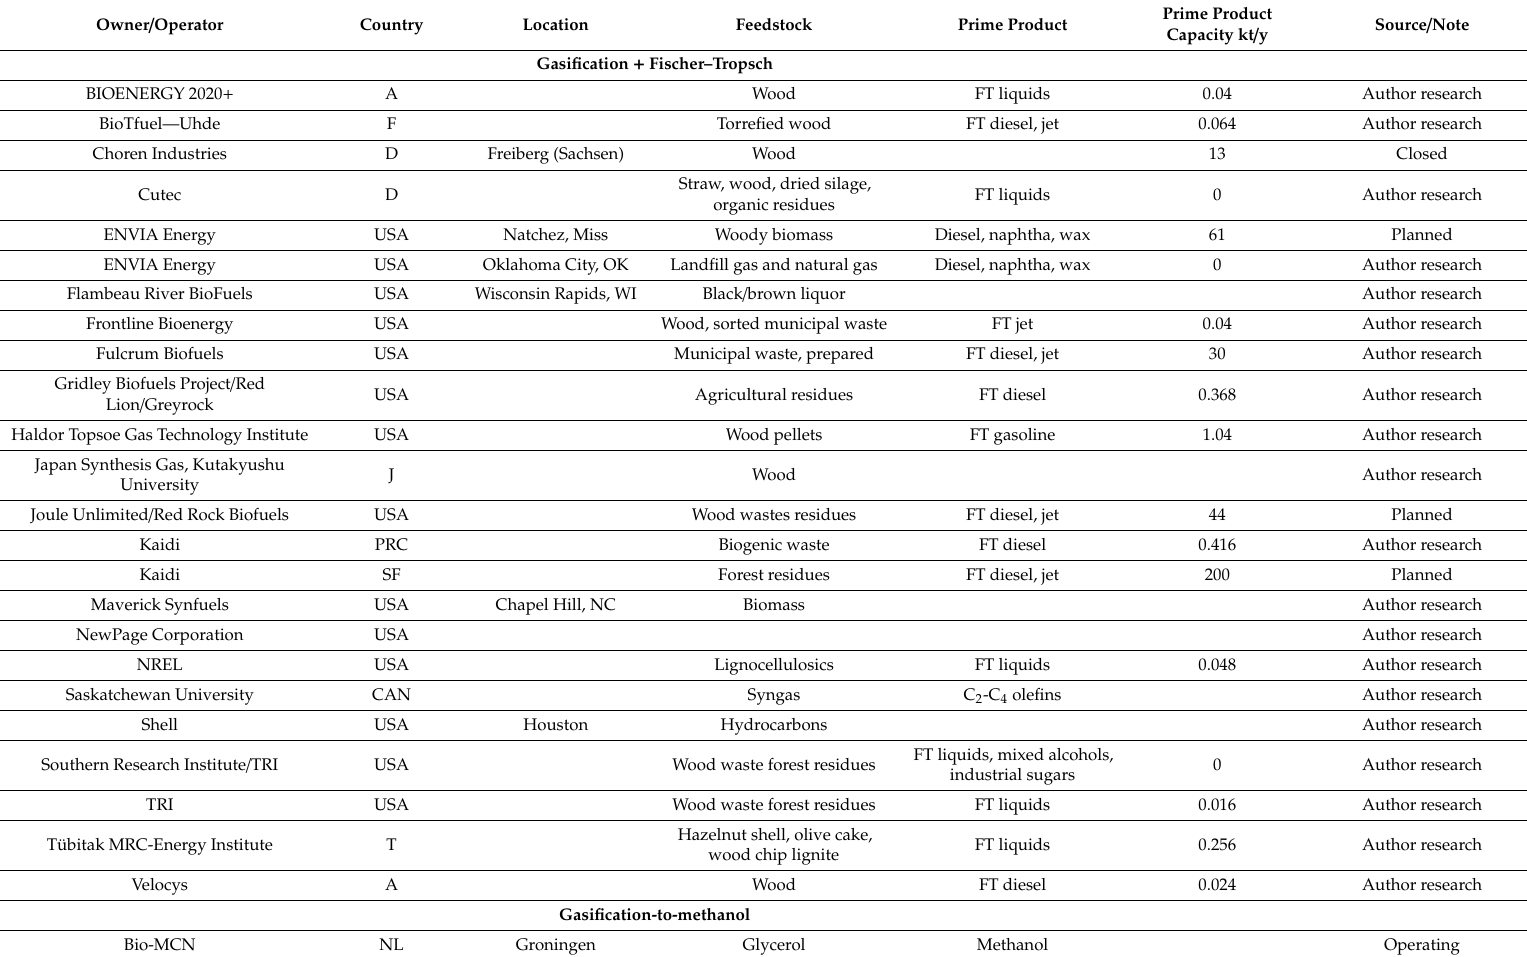
Table 10. Gaseous conversion and synthesis projects for BioLPG, by